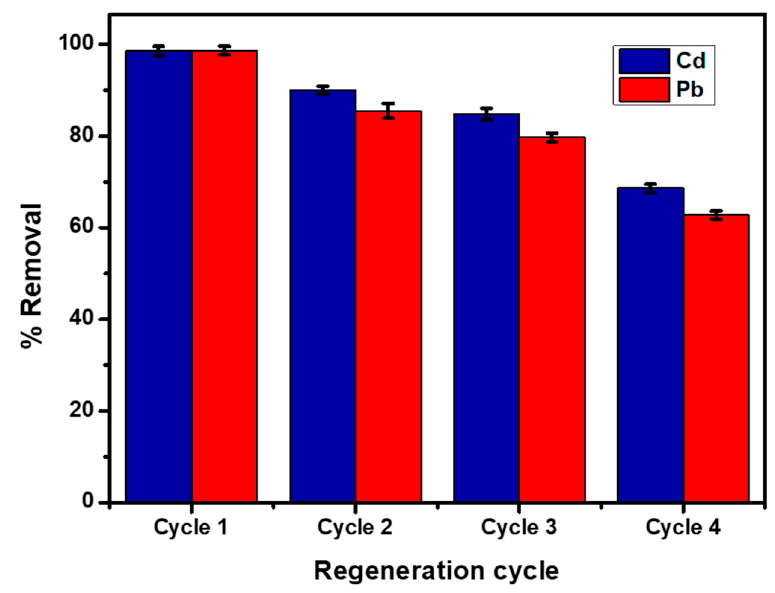
Figure 12. Regeneration for adsorption–desorption